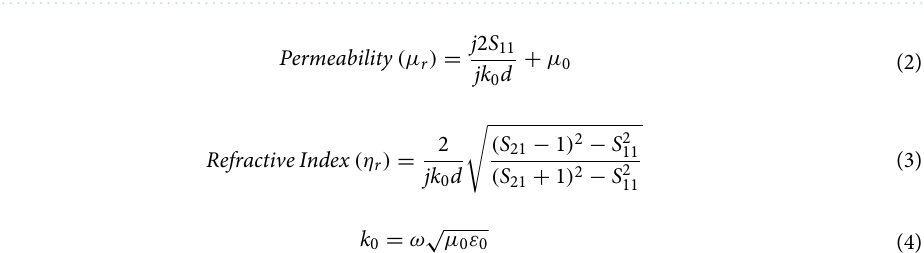
Figure 2. Spider net-shaped metamaterial unit cell: ( a ) MTM unit cell geometry; ( b , c ) Extracted effective parameters. The dimensions of the unit cell (mm): M w = 9, M L = 9, g 1 = g 2 = t 1 =